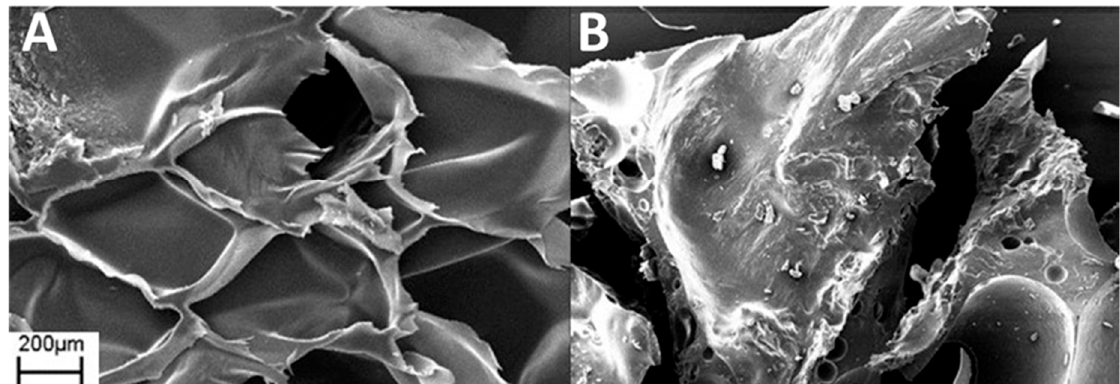
Figure 10. SEM images of PSS/GNPs coating ( A ) and PSS/GNPs coating after the vertical burning test ( B ).